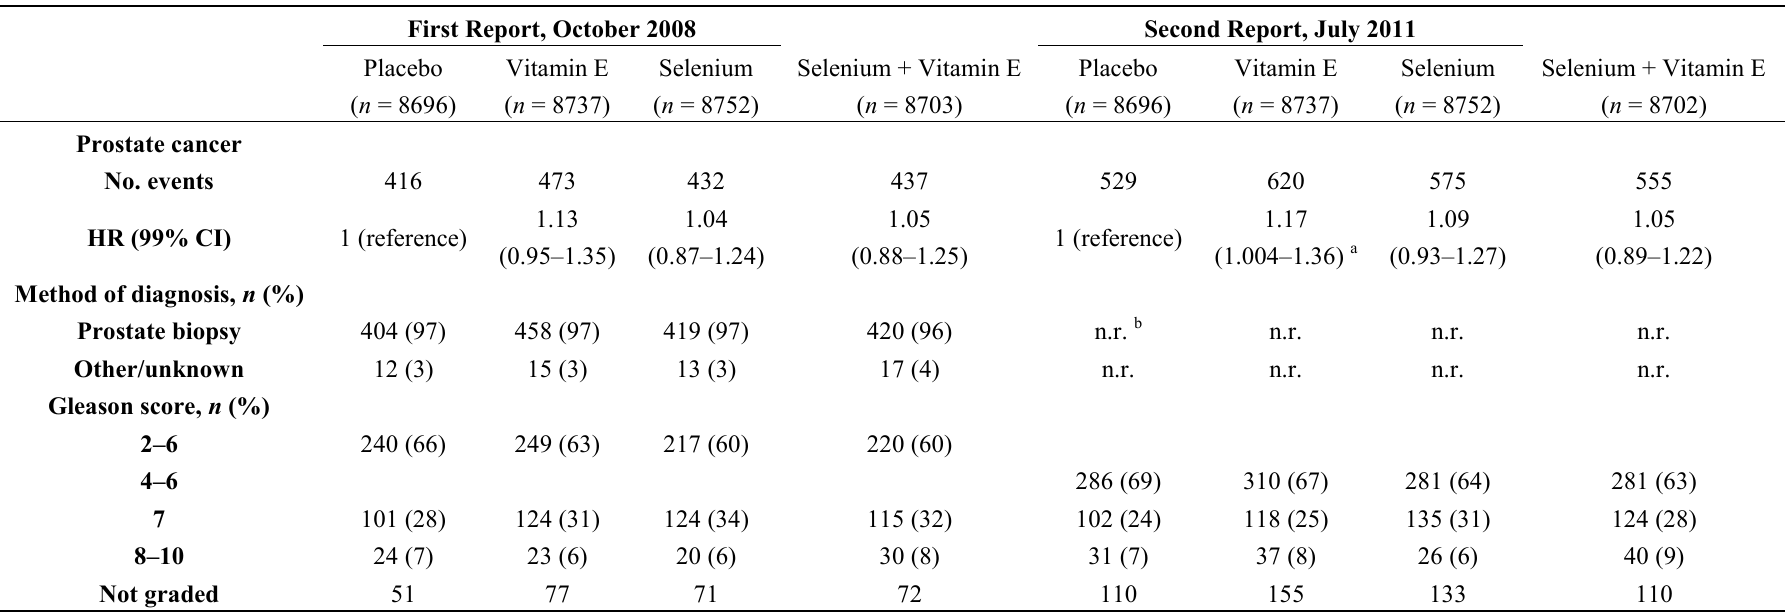
Table 2. Primary endpoint results from SELECT, first and second reports